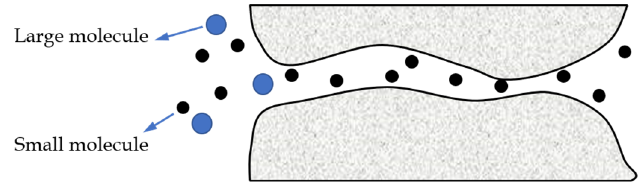
Figure 4. A schematic representation of the molecular sieving effect.